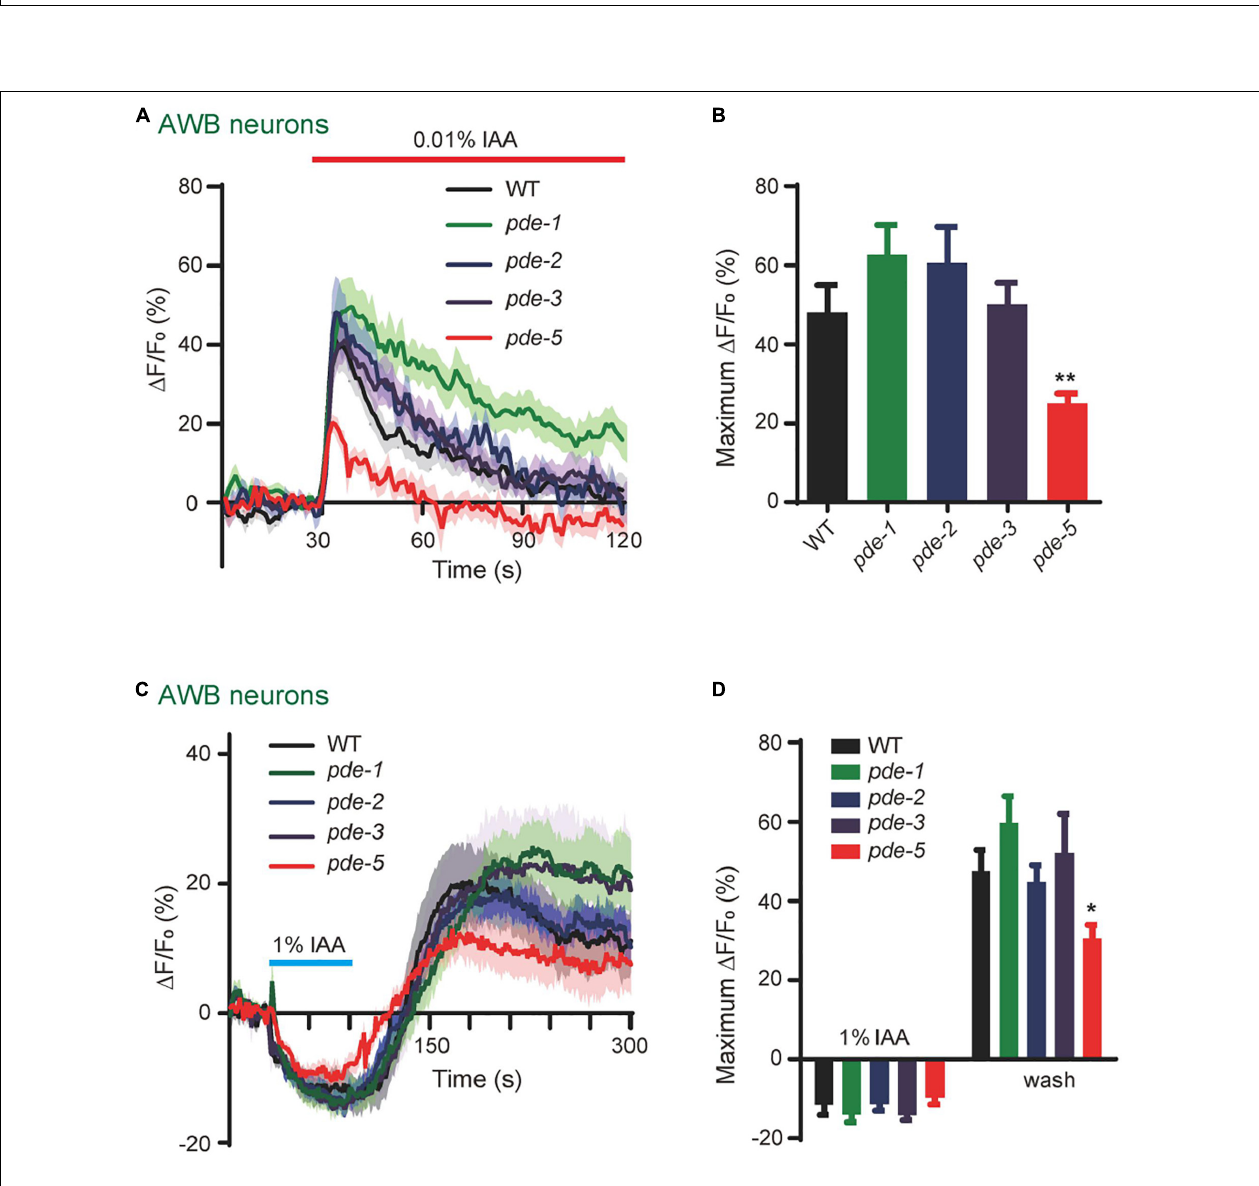
FIGURE 6 | PDE-5 is involved in olfactory encoding in AWB neurons. (A,B) 0.01% IAA-induced calcium increases in AWB neurons were reduced in pde-5(nj49) mutants. (A) Representative traces. (B) Quantification of the maximum (cid:49) F/F 0 . n ≥ 10. (C,D) 1% IAA removal-induced calcium increases in AWB neurons were reduced in pde-5(nj49) mutants. (C) Representative traces. (D) Quantification of the maximum (cid:49) F/F 0 . n ≥ 11. Error bars: SEM. N.S., not significant, * P < 0.05, ** P < 0.01.